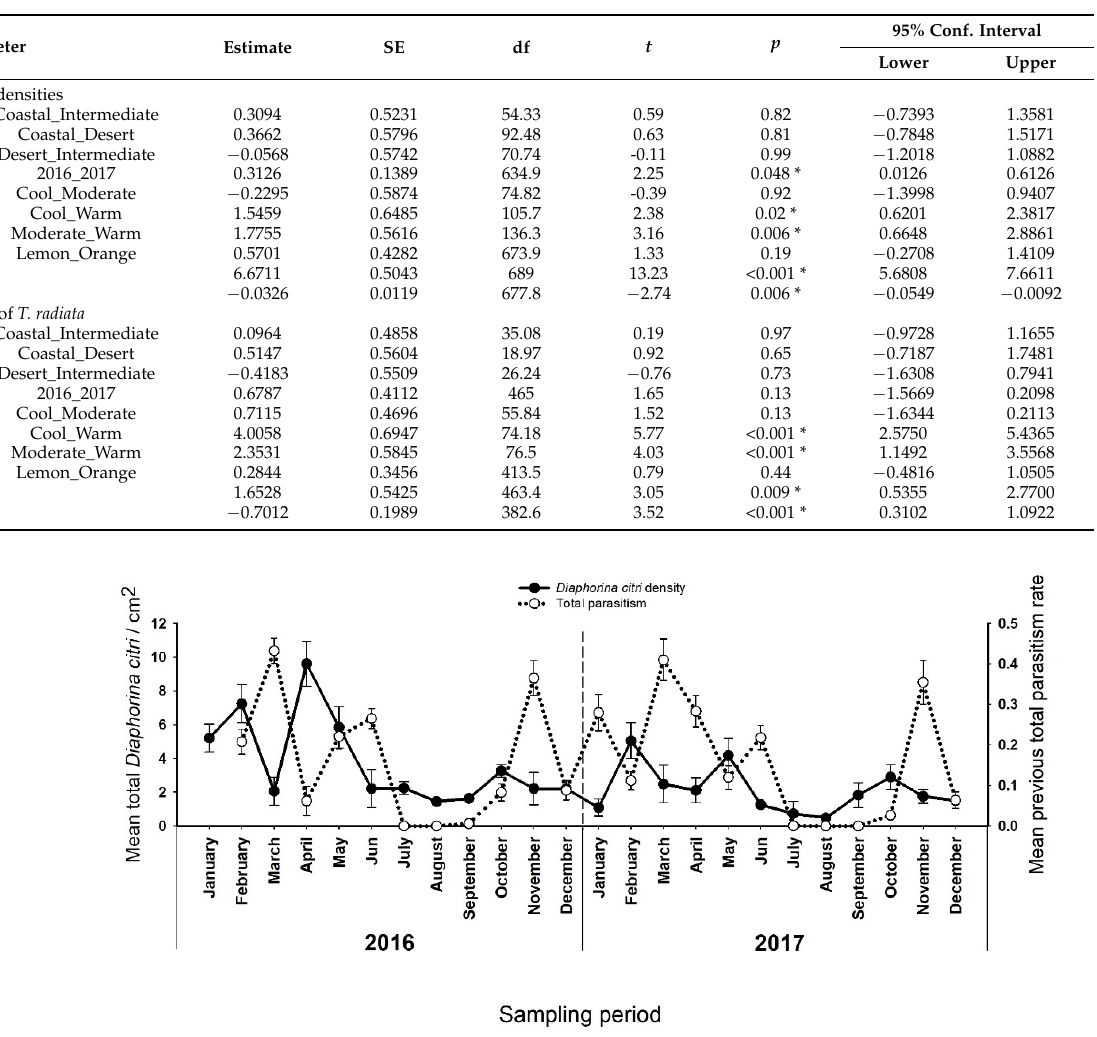
Figure 2. The relationship between Diaphorina citri densities and total parasitism rates across field sites from January 2016 through December 2017. Mean ( ± SE) total D. citri population densities (pooled across all psyllid life stages) and mean ( ± SE) total parasitism rates (pooled across Tamarixia radiata and Diaphorencyrtus aligarhensis parasitism rates) from the previous sampling interval (pooled across climate types and host plants) are shown. Table 2. Results of generalized linear mixed ‐ effects models examining the main and interaction ef ‐ fects of climate type and host plants on recorded (A) total psyllid densities and (B) parasitism rates of T. radiata at field sites from January 2016 through December 2017. The selected regression model for psyllid abundance also included a covariate of total parasitism rates from the prior sampling period (A). The selected regression model for parasitism rates of T. radiata also included a covariate of densities of late fourth and fifth instar psyllid nymphs from the previous sampling period (B). The final minimal and most adequate regression models for each response variable are presented below. The critical level of significance was set at 0.05*